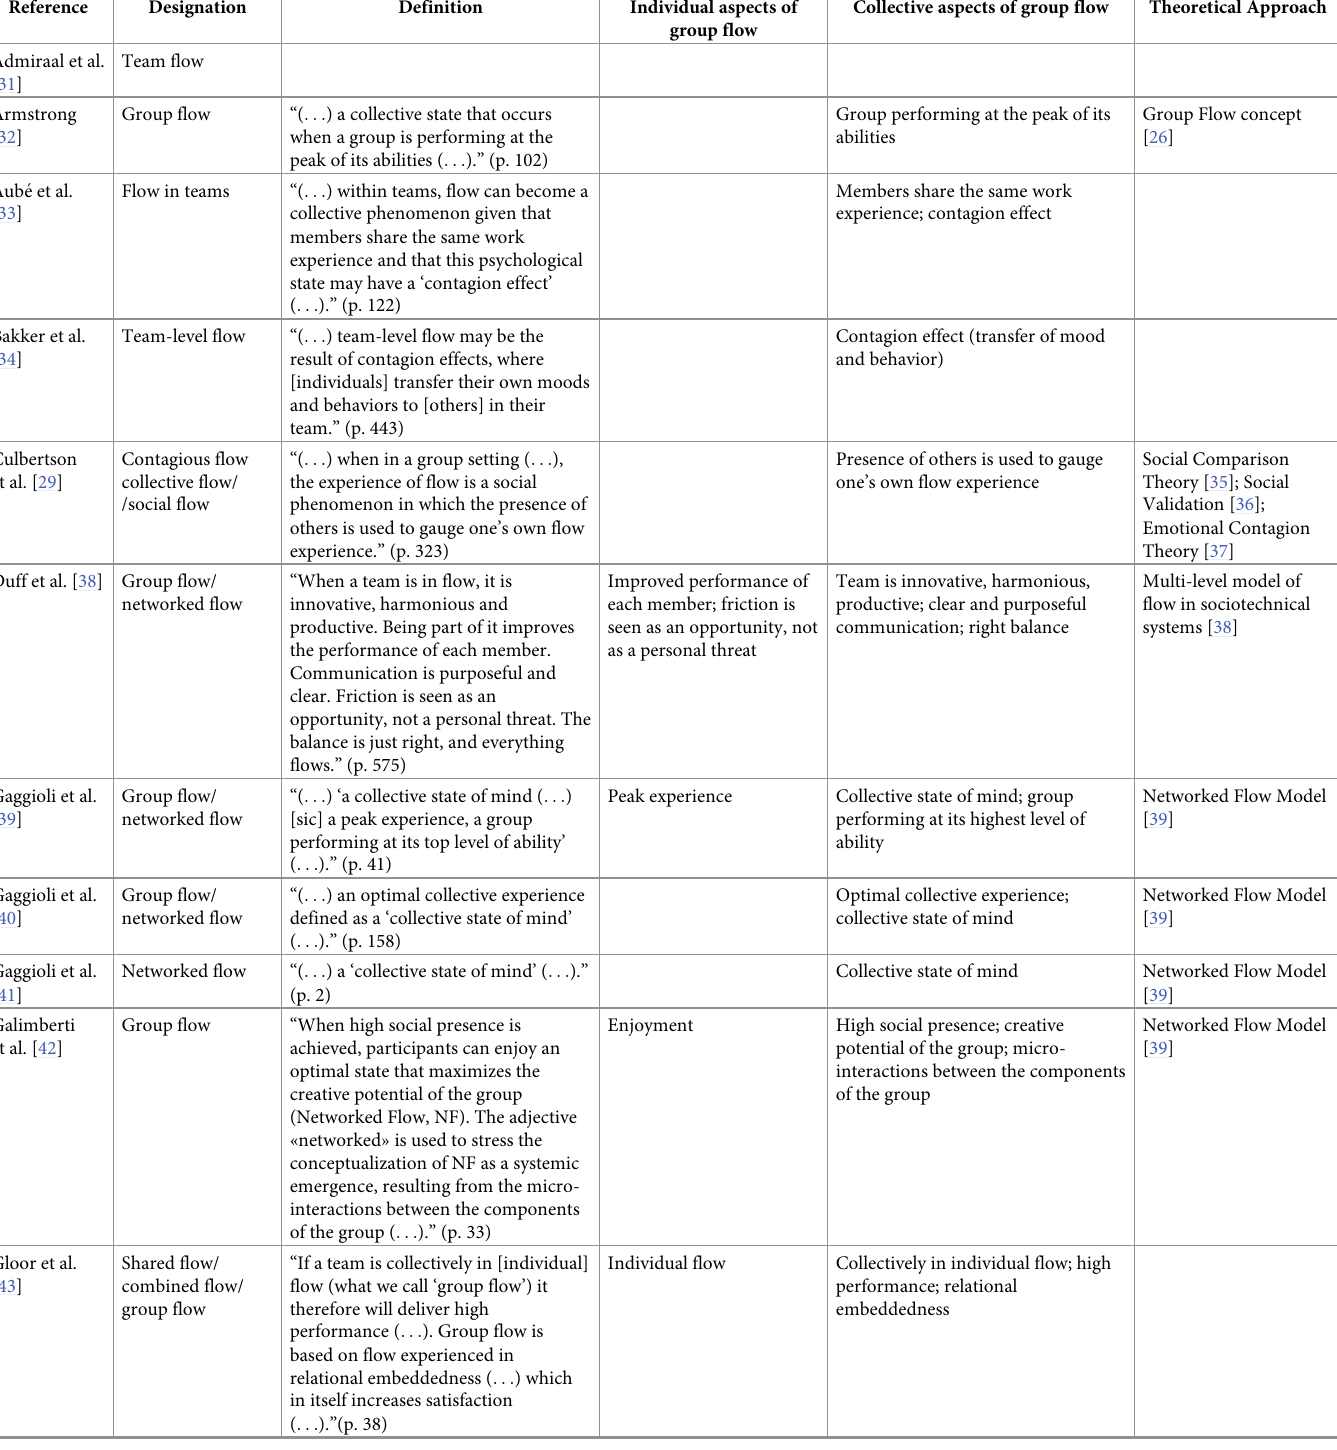
Table 1. Group flow designations, definitions and theoretical approaches of reviewed